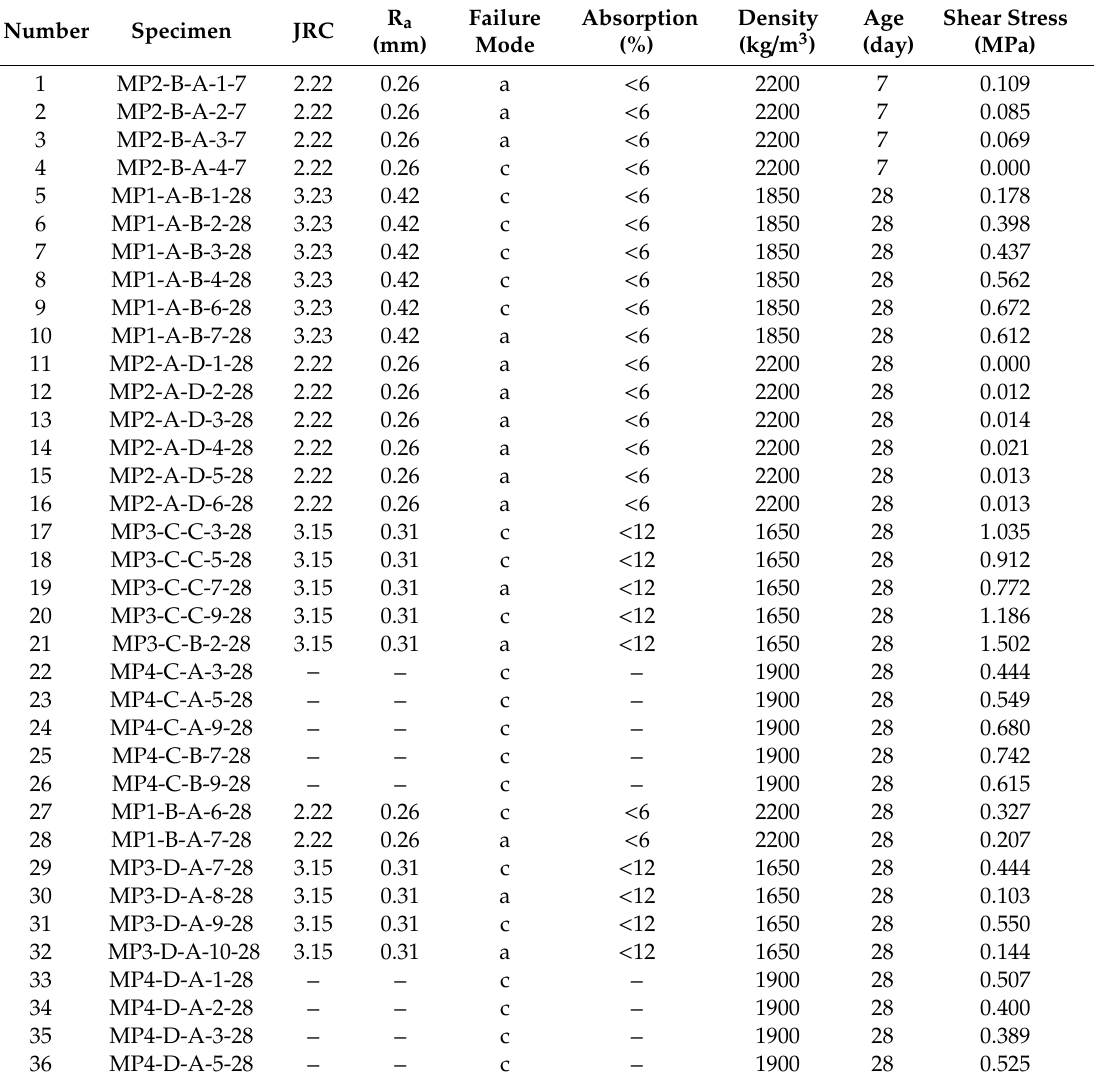
Table A4. Specimen details and test results of shear